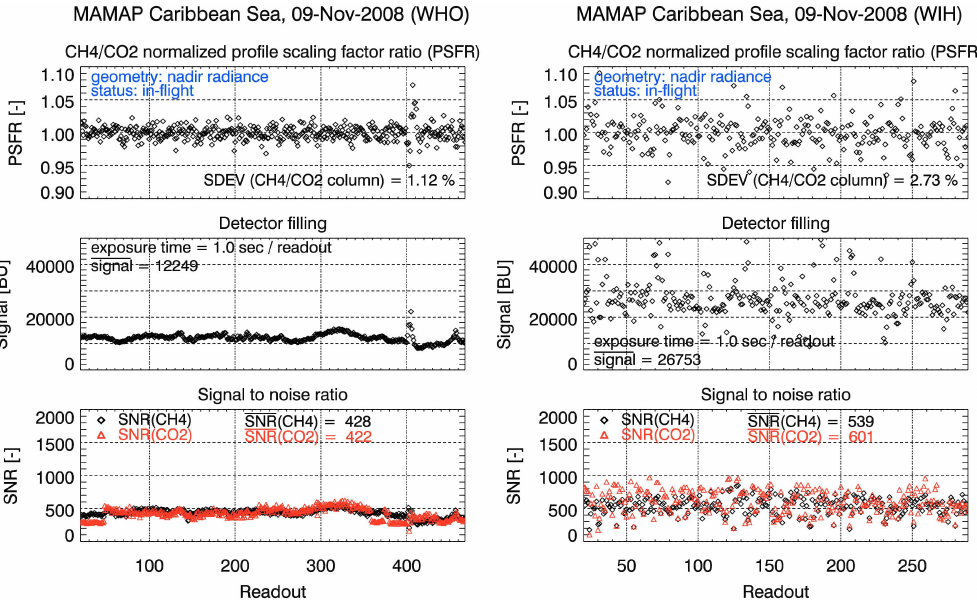
Fig. 9. As Fig. 8 but for in-flight nadir measurements over water; left: scene with homogeneous reflectance distribution (target WHO); right: scenes with inhomogeneous reflectance distribution (target